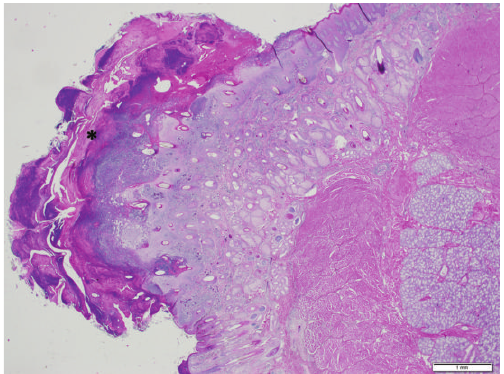
Figure 4: Haired skin, lip commissure. Focally extensive, severe, proliferative, and necrotizing dermatitis, with epithelial hyperplasia, necrosisandlosswithreplacementbyaserocellularcrust( ∗ ).Hema- toxylin and eosin stain, 2x objective.